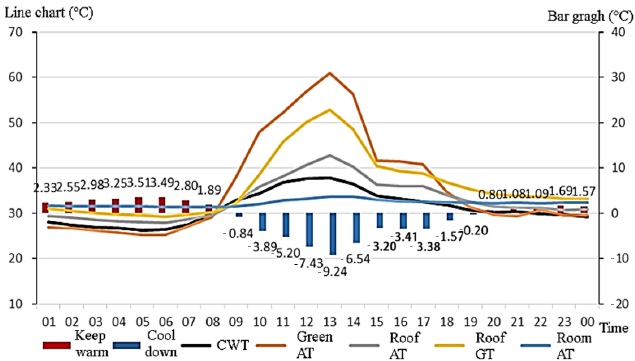
Figure 7. Ambient temperature trends of the ecological terrace on 27 May.